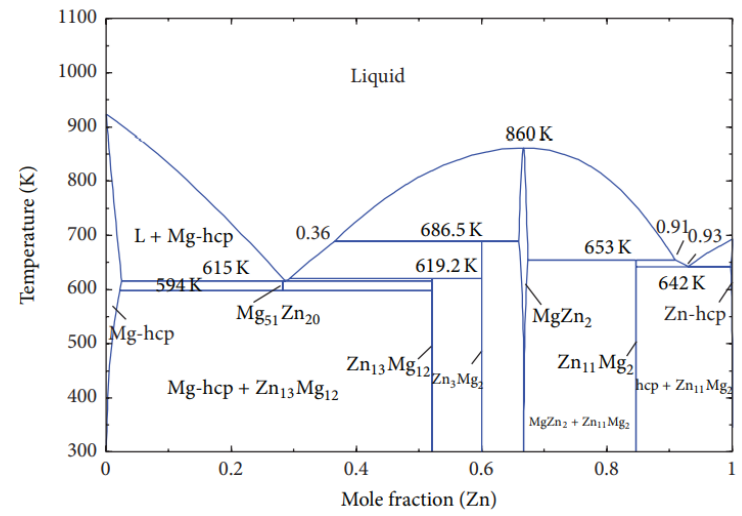
Figure 4. Mg-Zn phase diagram [119].